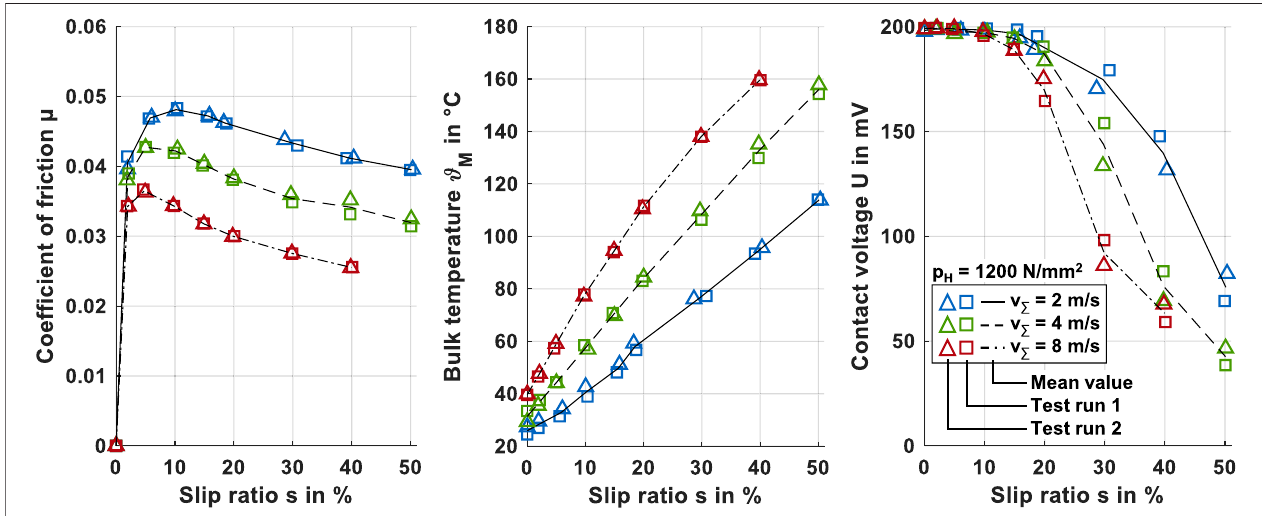
FIGURE9| Measuredcoef fi cientsoffrictionµ,bulktemperatures ϑ M andcontactvoltagesUoverslipratiosforp H (cid:1) 1200 N/mm 2 andv Σ (cid:1) {2,4,8} m/sunderDoD lubrication at the twin-disk tribometer.